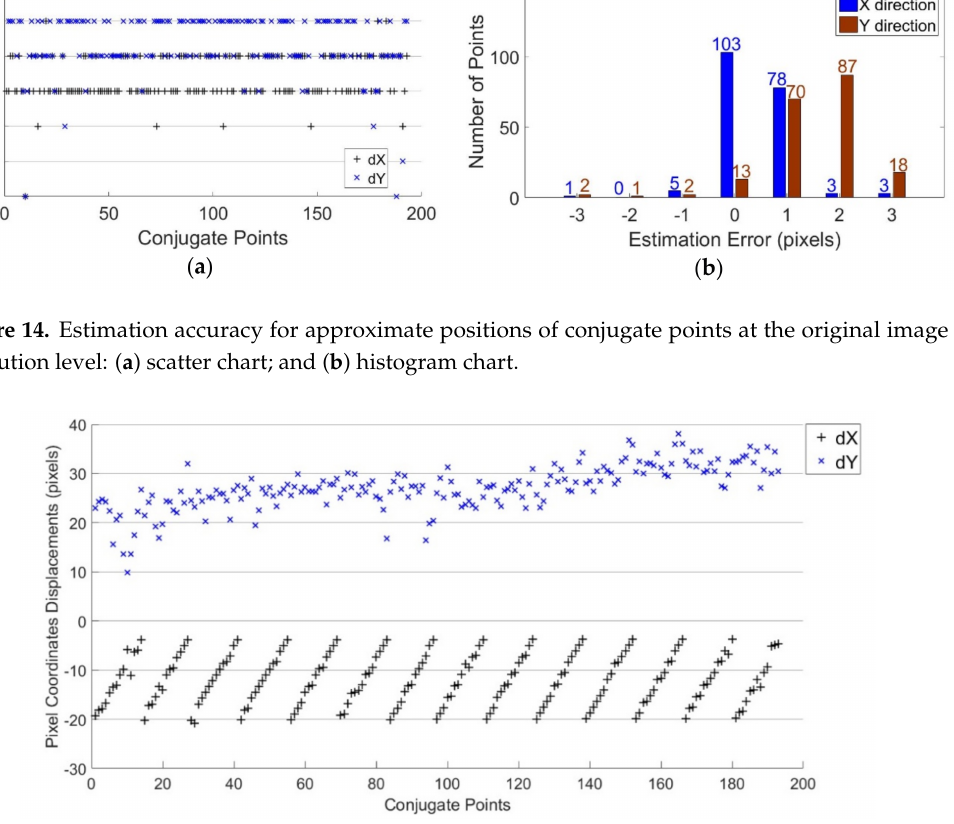
Figure 15. Pixel coordinate displacements (PCDs) of conjugate points on the original HRSC Level-2